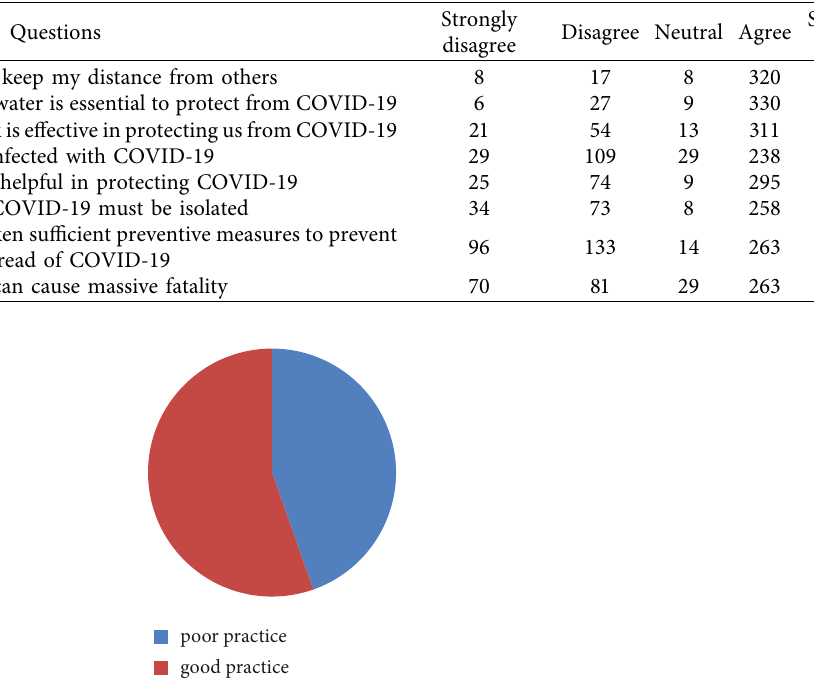
Figure 3: Total distribution of respondents according to their practice on COVID-19 in Dessie town, Ethiopia, 2020.